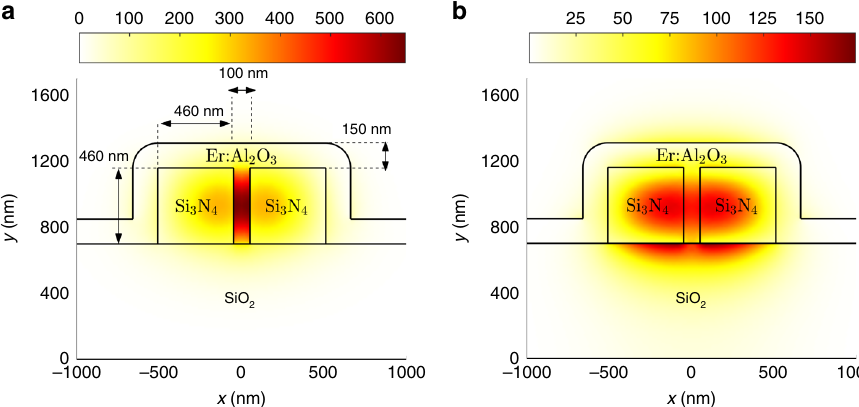
Fig. 4 Modal analysis of the hybrid slot waveguides. a Simpli fi ed cross-section and electric fi eld distribution (| E x | 2 ) of the fi rst-order TE-mode at λ = 1533 nm of the studied Er:Al 2 O 3 – Si 3 N 4 hybrid slot waveguides. b Electric fi eld distribution (| E y | 2 ) of the fi rst-order TM-mode for the corresponding cross-section and wavelength. The following refractive indices were used in the modeling: n